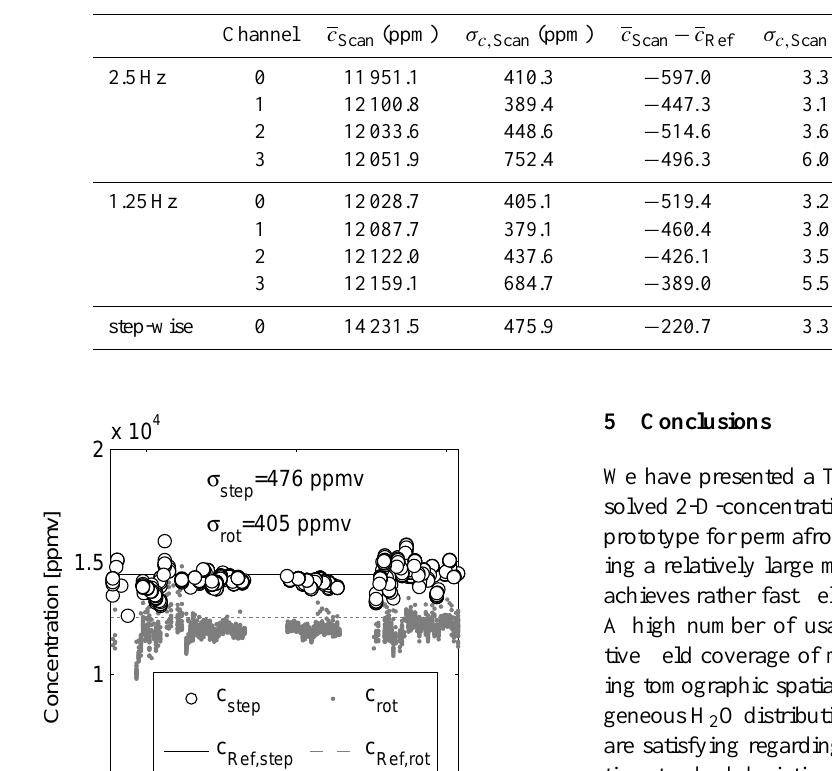
Table 1. H 2 O concentration performance of the scanning measurements compared with a static reference measurement and a step-wise scanning measurement.